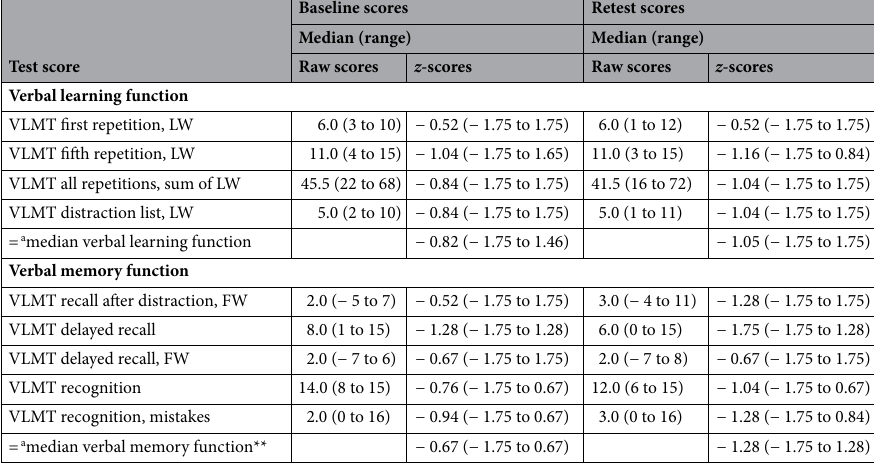
Table 3. Verbal learning and verbal memory function at the pre- and postsurgical assessment. LW, learned words; FW, forgotten words. a Median test scores compared between the two assessments using Wilcoxon tests, ** p <